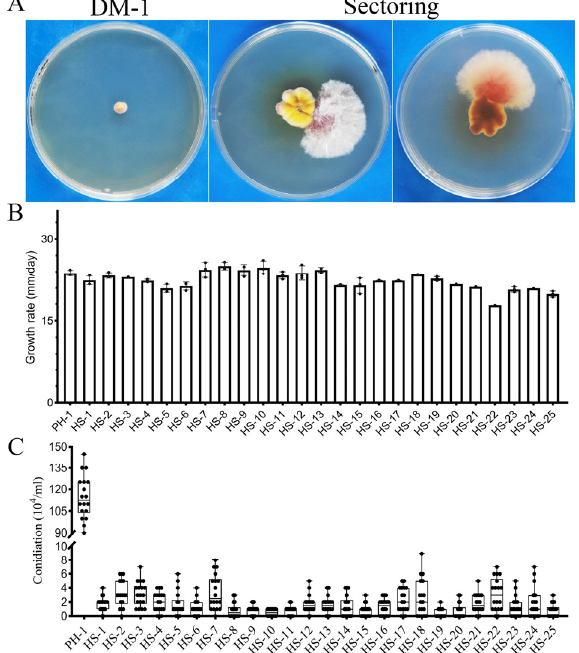
Figure 1. Spontaneous suppressors of the cpk1 cpk2 double mutant. ( A ) Three-day-old PDA cultures of the cpk1 cpk2 double mutant and cpk1 cpk2 double mutant with fast-growing sectors. ( B ) Assay of growth rate of the spontaneous suppressor strains. Mean and standard errors were estimated with data from three independent measurements. ( C ) Assay of conidiation of the spontaneous suppressor strains. Mean and standard errors were estimated with data from three independent measurements.